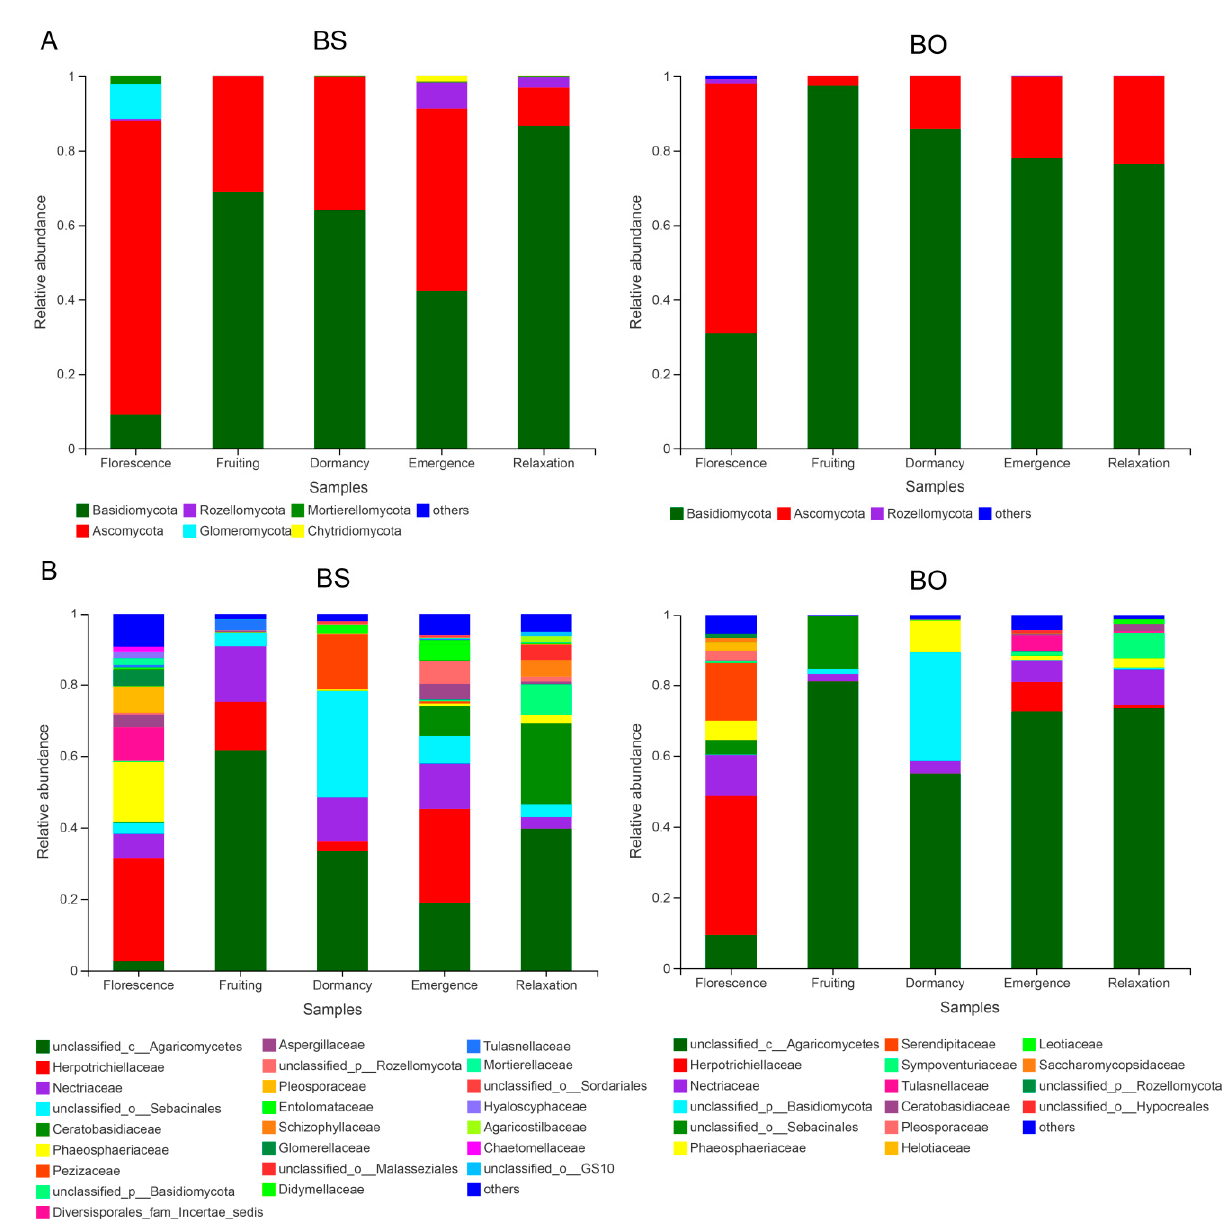
Figure 4. Relative abundances of mycorrhizal fungi in different phenological stages at different phylogenetic levels. ( A ) Relative abundances of mycorrhizal fungi at the phylum level. ( B ) Relative abundances of mycorrhizal fungi at the family level. BS and BO represent Bletilla striata and B. ochracea , respectively.